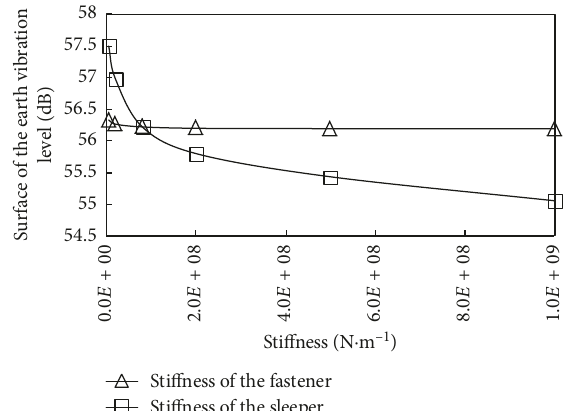
Figure 18: The influence of stiffness change on the vibration power level.